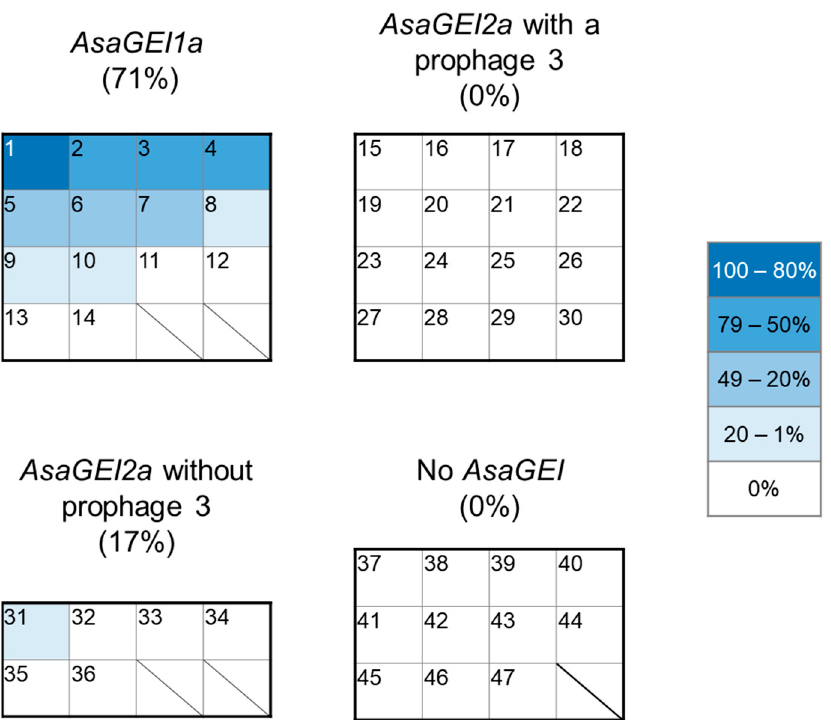
Figure 2. Systematic analysis of the TTSS locus loss in Canadian strains of A. salmonicida subsp. salmonicida after incubation at 25 °C for two consecutive periods of 3 days . Each numbered square corresponds to a strain. The strains where the TTSS locus loss has been observed are shown in blue. The percentage of rearrangement was calculated by the number of colonies that lost their TTSS out of the colonies tested (see Table S3 for the complete results).